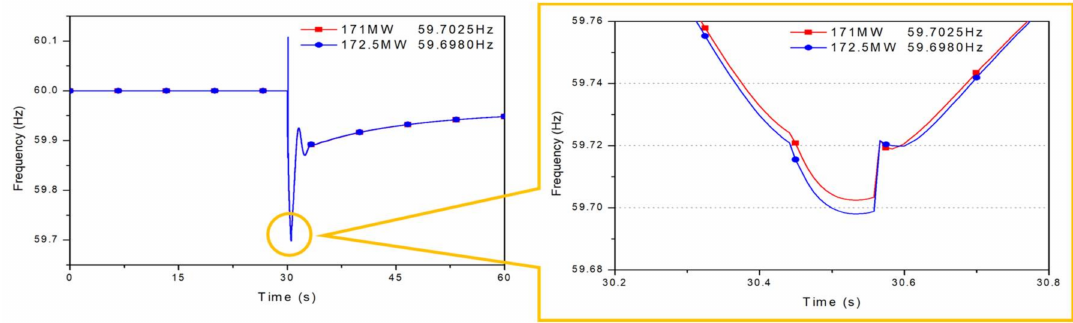
Figure 11. Frequency of Jeju power system at the merit order 3 when the wind farm is